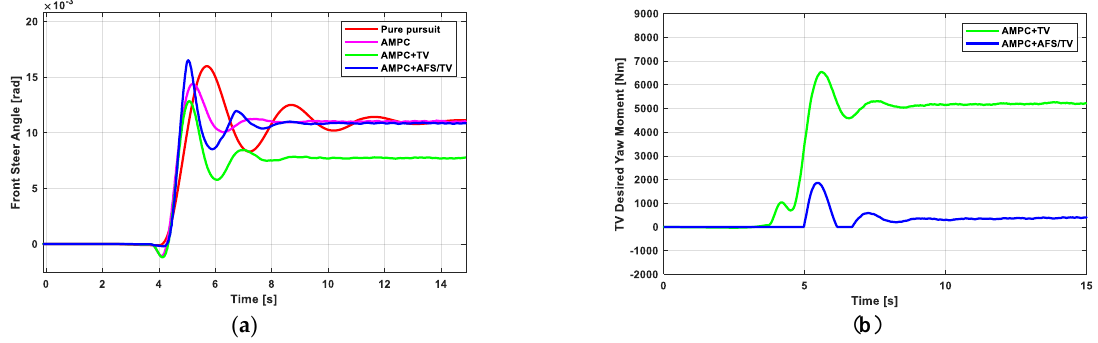
Figure 13. ( a ) Front steering angle and ( b ) desired yaw moment by TV.